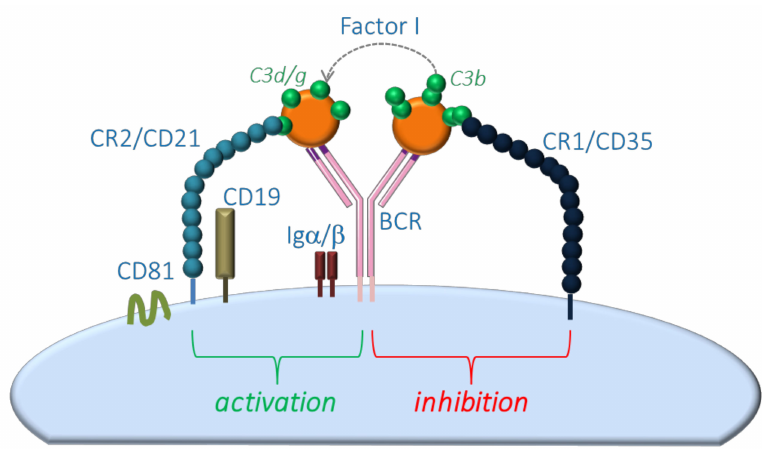
Figure 5. Model scheme of complement-mediated activation of mucosal naïve/memory B